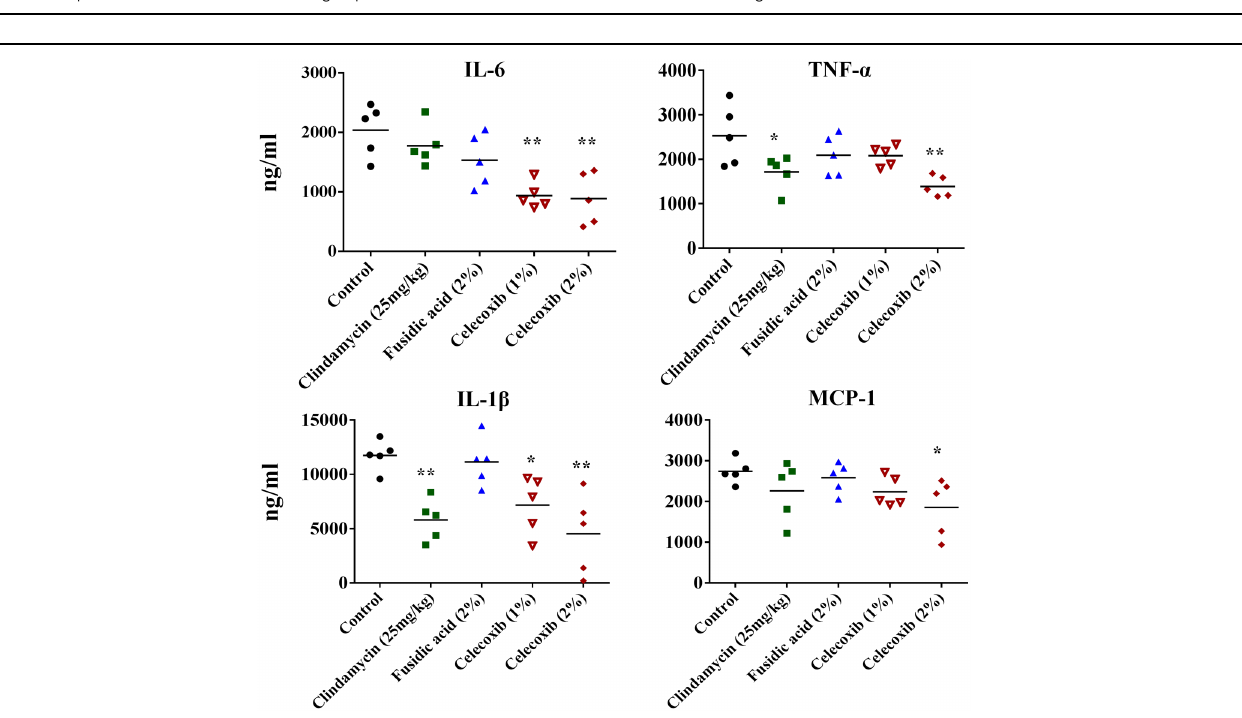
means ± SD ( n = 3). (B) Efficacy of treatment of MRSA-infected mouse skin lesions with celecoxib 1 and 2%, clindamycin (25 mg/kg), fusidic acid 2%, and petroleum jelly (negative control) twice daily for 5 days were evaluated. Five mice per group was used and the results were means ± SD of five mice. CFU per wound was calculated and presented. ∗ P ≤ 0.05 and ∗∗ P ≤ 0.01 were considered as significant.